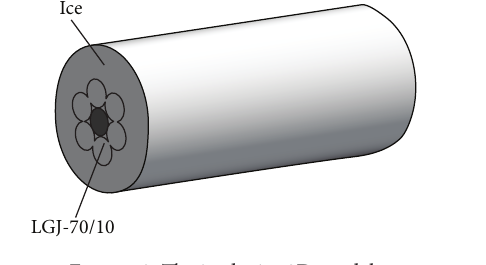
Figure 2: The iced wire 3D model. Table 1: Mechanical parameters of the wire.